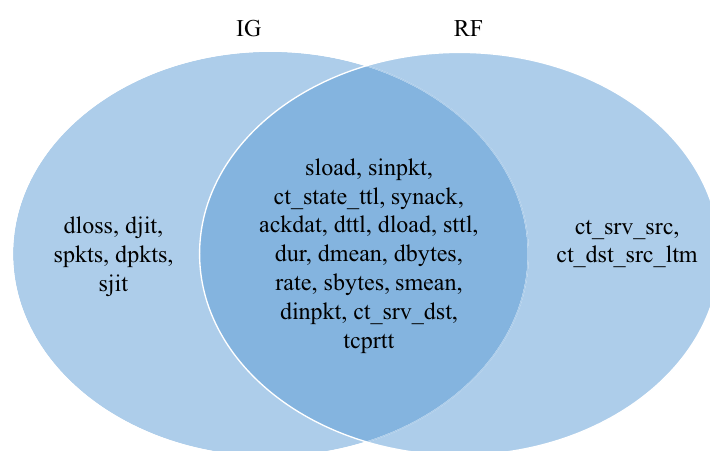
Fig. 10 Numeric feature union set of IG and RF feature